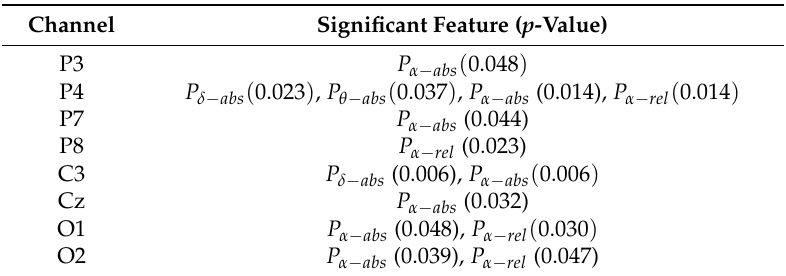
Table 2. Significant features obtained from the EEG power analysis.